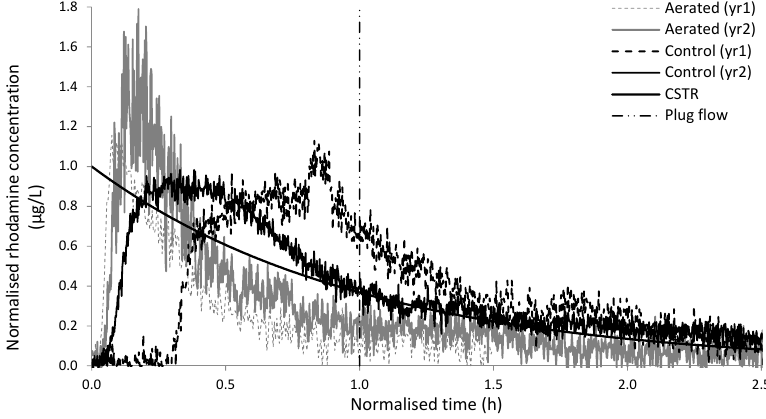
Figure 11. Year one and two residence time distributions for the aerated and control beds at Site A. Table 3. Hydraulic characterisation of HSSF CW with and without aeration.